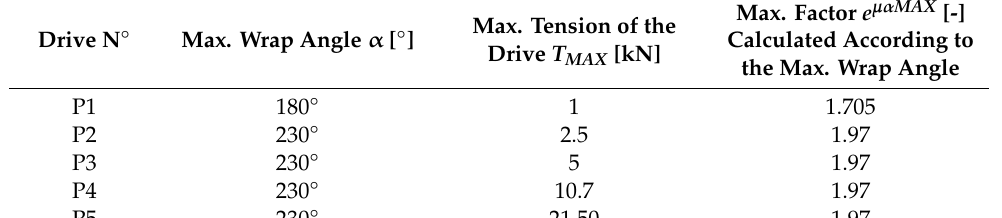
Figure 3. The arrangement of the bridle rolls in the real line used for simulation and experiment. The wrap angles α 1 – α 5 around tension rolls are different. Table 1. Properties of the drives in Figure 4 corresponding to a realistic annealing oven.